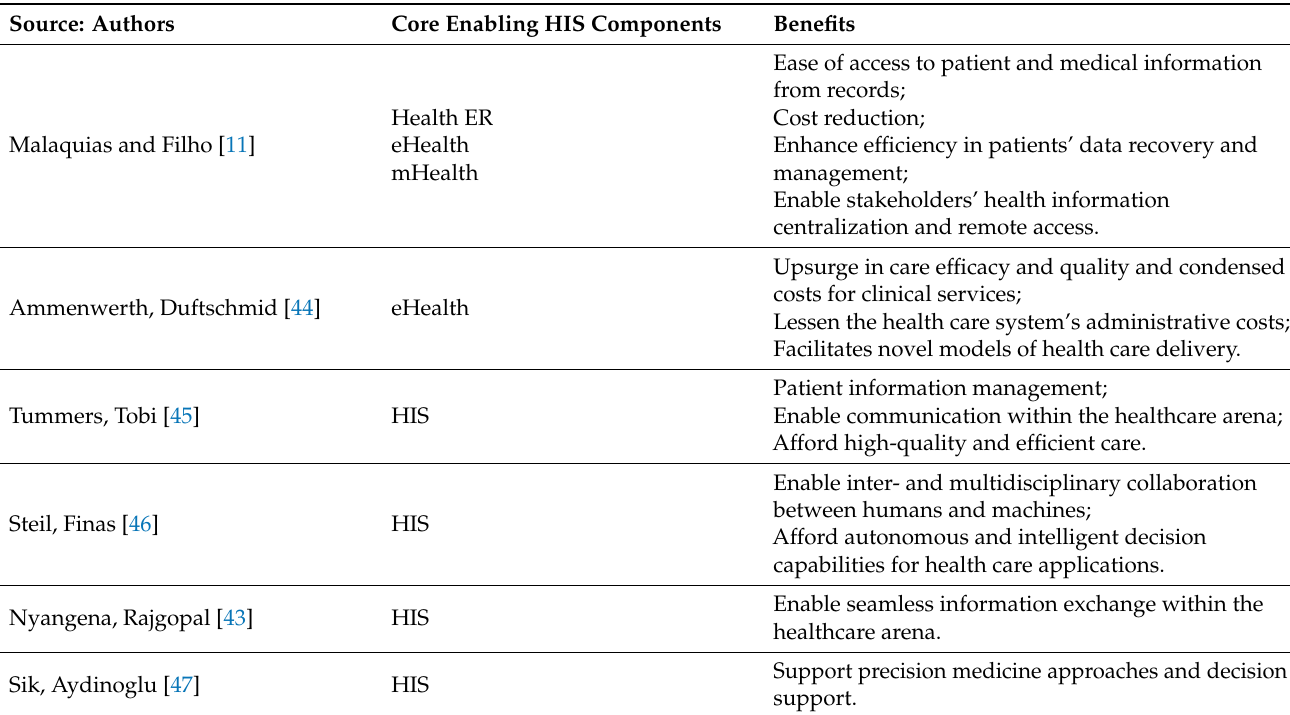
Table 1. HIS core enabling components and its